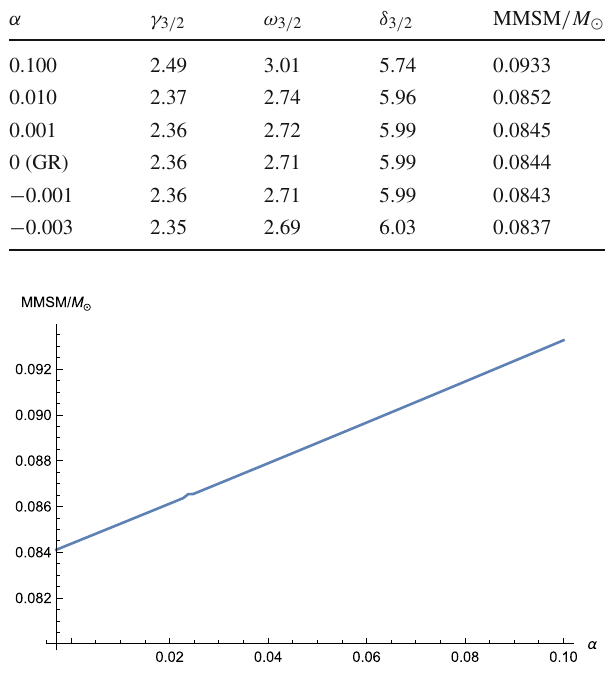
Fig. 2 The evolution of the MMSM (in units of solar masses) with the parameter α . The range in this plot goes from α ∈ ( − 0 . 003 , 0 . 10 ) , with the lower bound given by a well-defined solution of the extended Lane–Emden equation